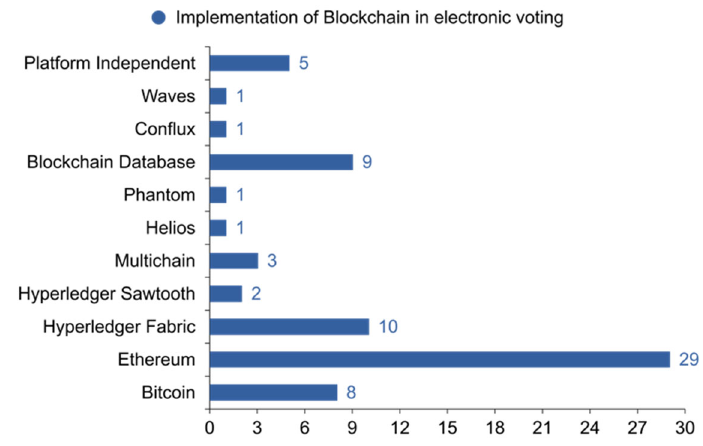
Figure 12. Implementation of Blockchain in electronic voting.